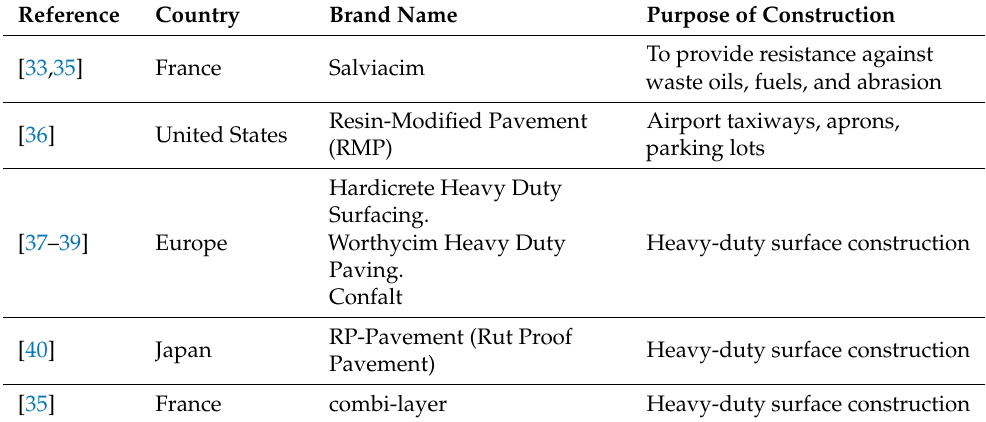
Table 1. Development and purpose of grouted macadam in the